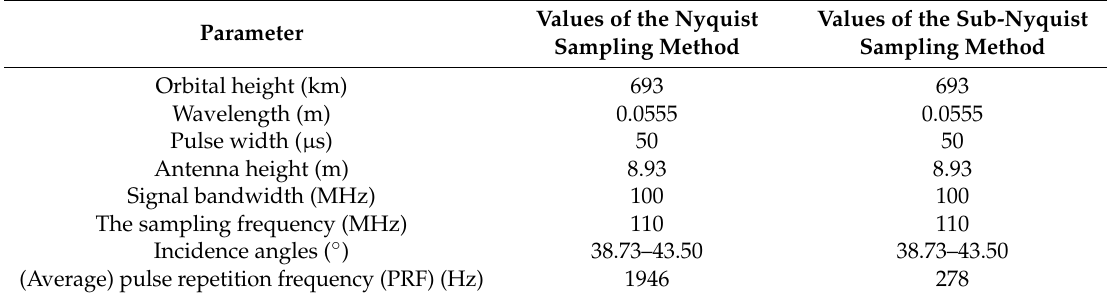
Table 1. Simulation parameters.